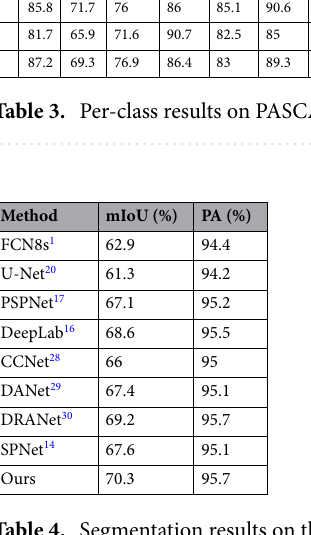
Table 4. Segmentation results on the CityScapes